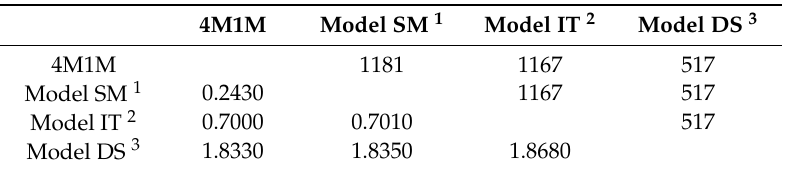
Table 6. Alignment of the models selected from each modeling tool with respect to the crystal structure of m P-gp (PDB: 4M1M). Main-chain RMSD (in angstrom) are below the diagonal and Number of Overlapping Residues above the diagonal.